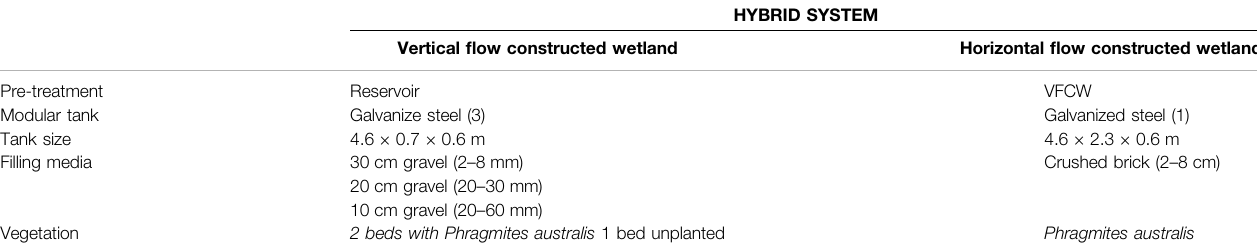
TABLE 1 | Main design parameters for the hybrid Constructed Wetland.